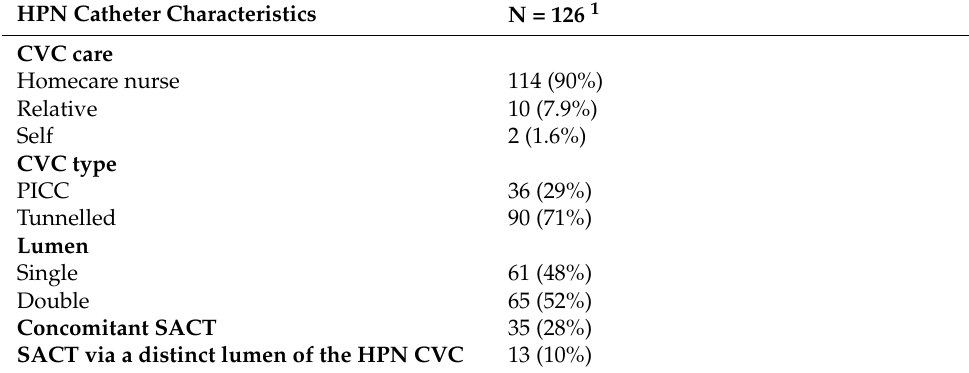
Table 2. Catheter